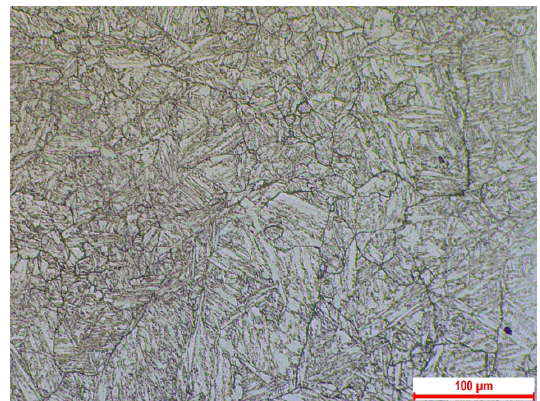
Figure 1. Light Microscope image of the microstructure of the T91 steel in the as-received state showing grain boundaries, bundles of martensite laths, and a few large carbide particles. Table 2. Mechanical properties of the test material determined in standard tensile tests of 10 − 4 s − 1 .